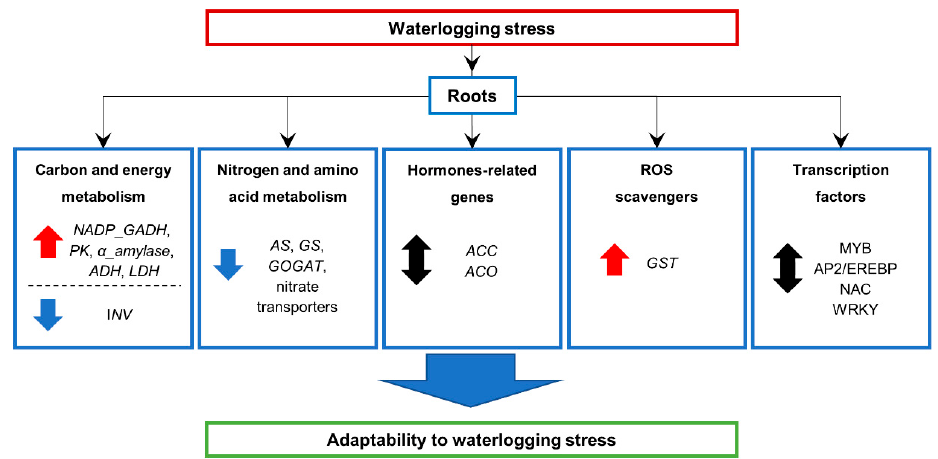
Figure 6. Schematic diagram of the main waterlogging stress responses in the roots of moderately- tolerant (72 h) and tolerant Deder2 (72 and 120 h) barley genotypes. NADP-GADH , NADP-dependent glyceraldehyde-3-phosphate dehydrogenase; PK , pyruvate kinase; ADH , alcohol dehydrogenase; LDH , lactate dehydrogenase; INV , acid β -fructofuranosidase; AS , asparagine synthetase; GS , glutamine synthetase; GOGAT , glutamate synthase; ACC , 1-aminocyclopropane-1-carboxylic acid synthase; ACO , 1-aminocyclopropane-1-carboxylic acid (ACC) synthase and ACC oxidase; GST , glutathione S-transferase; MYB, myeloblastosis; AP2 / EREBP, APETALA2 / Ethylene-responsive Element Binding Proteins; NAC, this acronym is derived from three genes that were initially discovered to contain a particular domain (the NAC domain): NAM (for no apical meristem), ATAF1 and − 2, and CUC2 (for cup-shaped cotyledon); WRKY, this TF binds a specific promoter sequence of the target gene, known as a W-box and the WRKY proteins contain one or two DNA binding domains of 60 amino acids containing the conserved heptapeptide WRKYGQK. Blue arrow indicates decreased expression, red arrow indicates increased expression, and black arrow indicates down-and up- regulation in Yerong roots at 72 h and Deder2 roots at 72 and 120 h of waterlogging treatment. Supplementary Materials: The following are available online at www.mdpi.com/xxx/s1, Figure S1: RNA-Seq and qRT-PCR validation data of five genes, Figure S2: Pearson correlation coefficient matrices, indicated by the 4 × 4 darker blue boxes, showing relationships between samples, Table S1: List of top highly expressed differentially expressed genes (logFC ≥ ±4 and adjusted p < 0.05) in the roots of Deder2 after 72 and 120 h of waterlogging, Table S2: Selected differentially expressed genes with altered expression in roots of waterlogged Yerong (72 h) and Deder2 (72 and 120 h) seedlings that are involved in major metabolism pathways, Table S3: Selected differentially expressed genes with altered expression in roots of waterlogged Yerong (72 h) and Deder2 (72 and 120 h) seedlings that are involved in hormones-related genes and reactive oxygen species (ROS) production pathways, Table S4: Summary of sequence assembly reads after Illumina sequencing (average of 4 biological replicates), Table S5: Overview of mapping status by RNA-Seq (average of 4 biological replicates), Table S6: Primer sequences and amplification efficiency for five target waterlogging related genes and three reference genes. Author Contributions: Conceptualization, A.B.-B., A.B.; methodology, A.B.-B., A.C., J.R.T., A.B.; analysis: A.B.-B., A.C., Z.Y., W.X.; writing—original draft preparation, A.B.-B., A.C., W.X., A.B.; writing—review and editing, A.B.-B., A.C, J.R.T., Z.Y., W.X., A.B.; supervision and project administration, A.B.; funding acquisition; A.B., A.B.B. All authors read and approved the final manuscript. Funding: This research was funded by Western Grains Research Foundation and Agriculture & Agri-Food Canada (AAFC) under the Growing Forward 2 program and Manitoba Wheat and Barley Growers Association. Acknowledgments: We gratefully thank Rudy von Hertzberg and Bryan Graham from AAFC Brandon Research and Development Centre for technical assistance. We also thank Meixue Zhou, Professor in Plant Breeding Barley and Plant Stress Tolerance, Tasmanian Institute of Agriculture and School of Land and Food, Australia